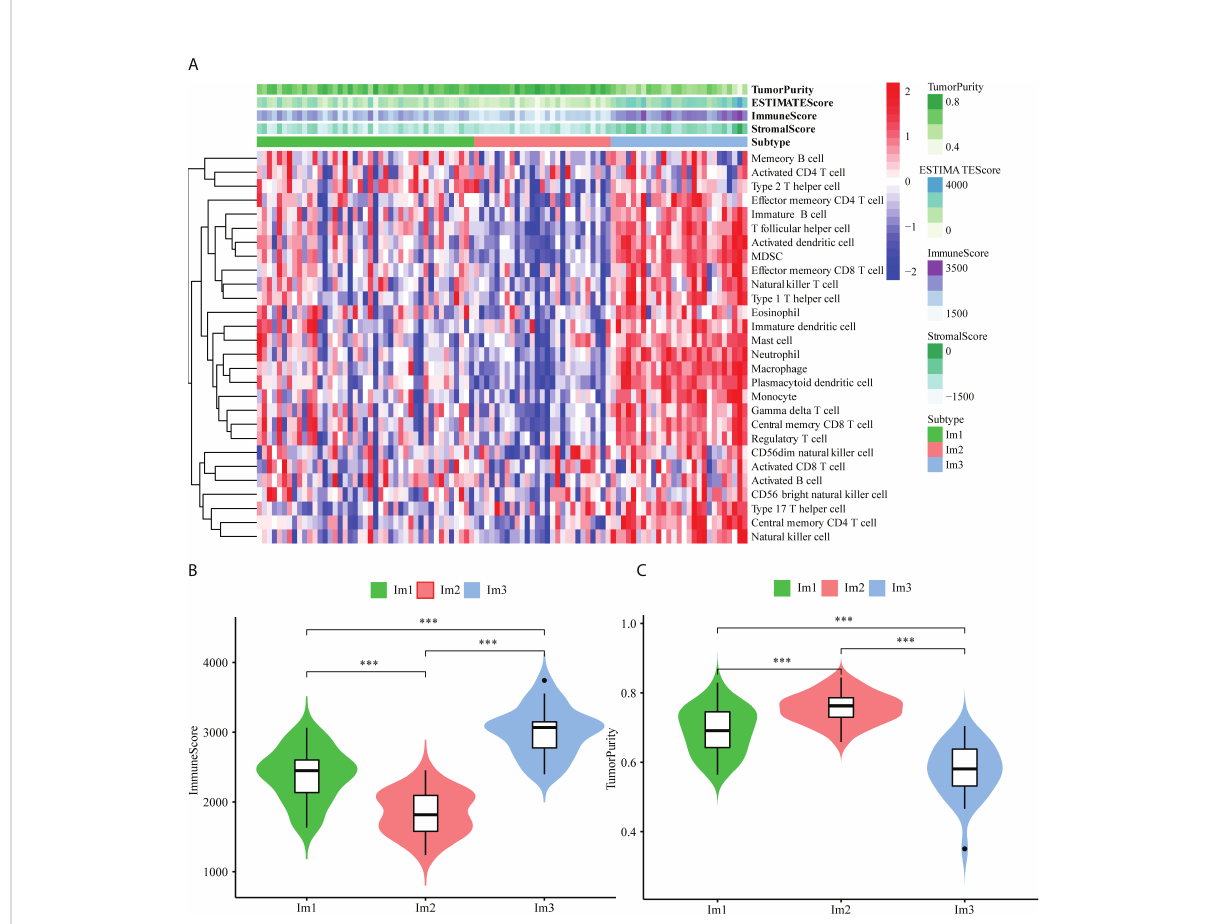
FIGURE 2 Immune functional characters of 3 AML patients clusters. (A) Heatmap of the Im1, Im2 and Im3 cohorts of 97 TCGA-AML patients using ssGSEA scores from 28 immune cell types. Violin plots depict the immune score (B) and tumor purity (C) of the Im1, Im2 and Im3 cohorts (***: